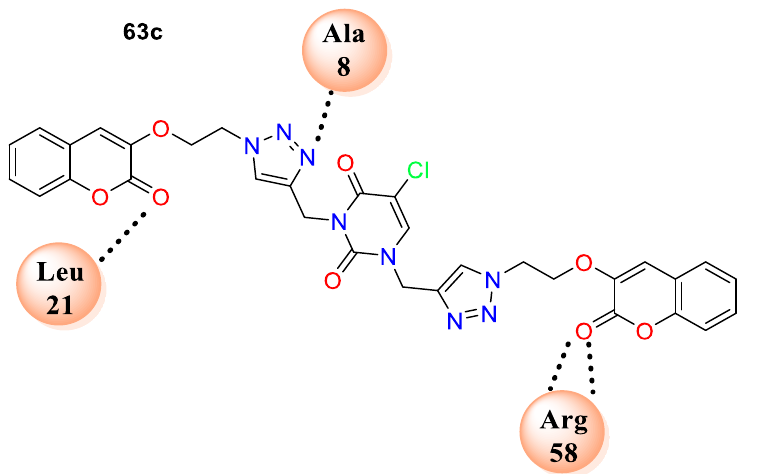
Figure 5. Two-dimensional representation of compound 63c with a binding site of S. Aureus dihydrofolate reductase (PDB ID: 3SRQ).